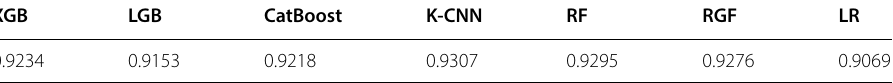
XGB stands for XGBoost; LGB for LightGBM; K-CNN the Keras [66] implementation of Convolutional Neural Networks; RF for Random Forest; RGF for Regularized Greedy Forest; performance in terms of Normalized Gini Coefficient